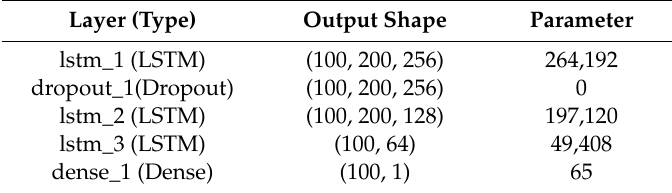
Table 1. LSTM Network Model Overview.